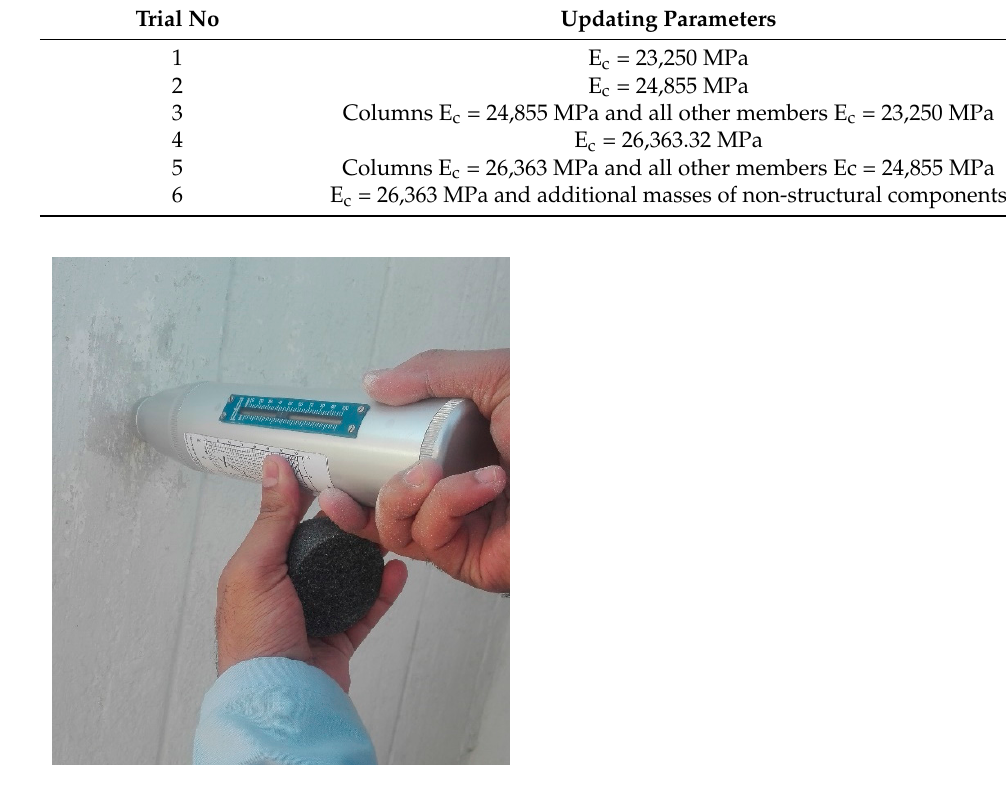
Table 5. Manual model updating scheme.